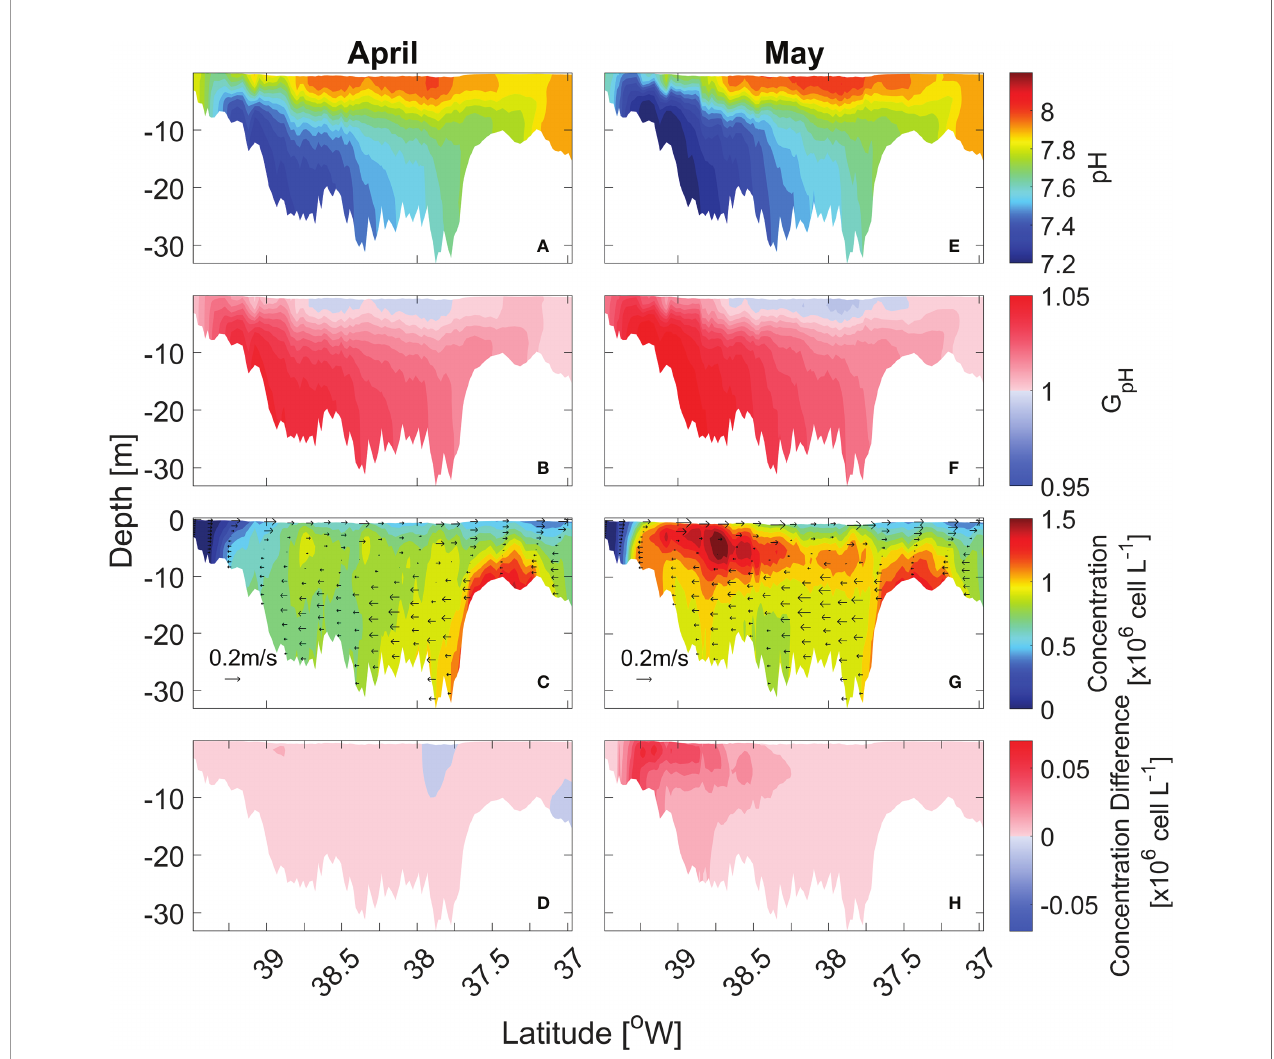
FIGURE 6 | Along-channel distribution of monthly-mean pH (A, E) , G pH (B, F) , P. minimum cell concentration (C, G) and the concentration difference between model with pH and without pH (D, H) in April and May in year